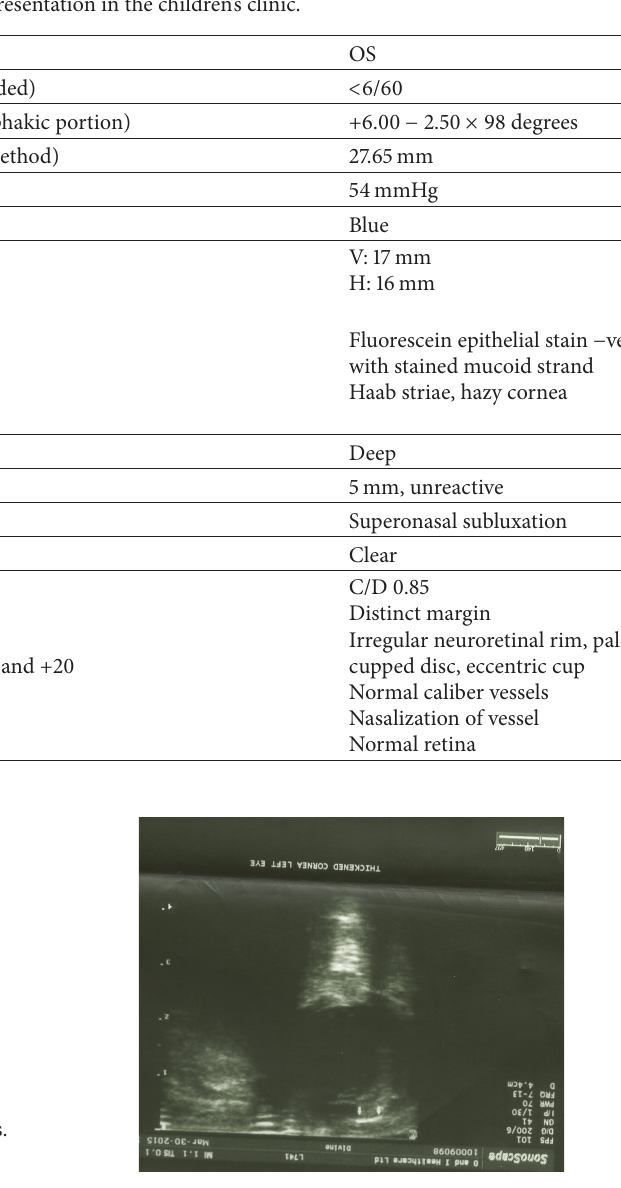
Figure 2: Left B ocular scan day #1 after operation showing suprachoroidal